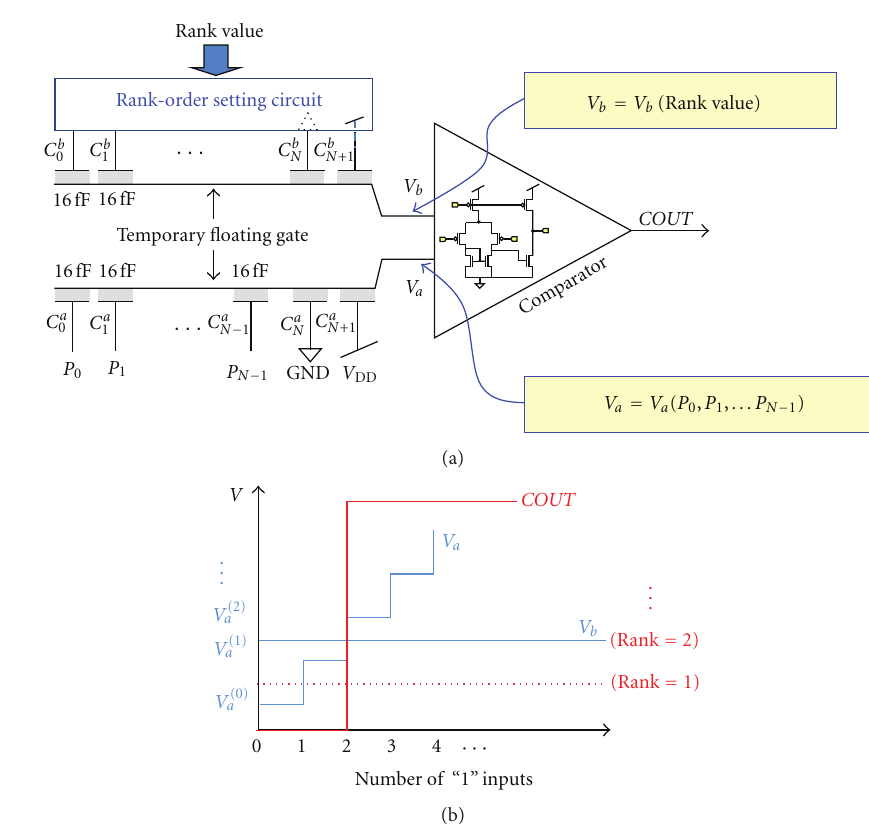
F 2: Floating-gate-MOS-based